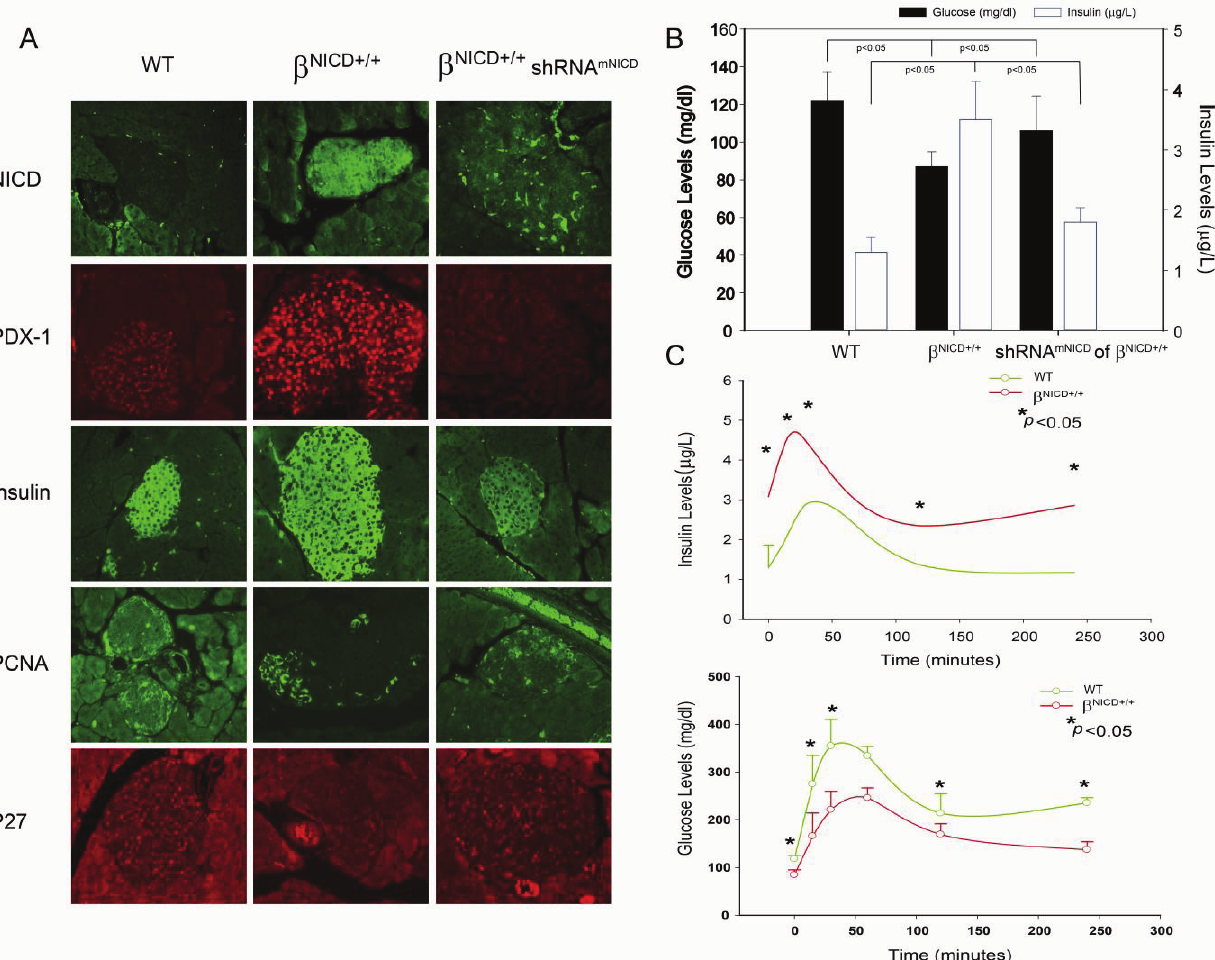
Figure 3. Overexpression of NICD-induced increase of PDX-1 expression is accompanied by the development of hypoglycemia and hyperinsulinemia in a β NICD+/+ transgenic mouse model. ( A ) Whole pancreatic tissues isolated from control mice (WT), β NICD+/+ mice and β NICD+/+ treated with shRNA mNICD were fixed in 4% (v/v) paraformaldehyde and embedded in paraffin. Immunohistochemistry analyses were performed using antibodies against NICD, PDX-1 (1:200), insulin (1:75), PCNA and p27. Fluorescence was developed using cy3- or FITC-conjugated secondary antibody. Photomicrographs were taken under 100× magnification. ( B ) Fifty (50) μ L of whole blood samples were collected from control mice (WT), β NICD+/+ mice and β NICD+/+ mice treated with shRNA mNICD and spun to separate the serum. Glucose levels were measured using a Beckman-Coulter Glucose Analyzer 2 (Coulter-Beckman, Fullerton, CA, USA), and presented as mean ± S.E.M. in mg/dl. Insulin levels were determined using a mouse insulin ELISA kit from Mercodia (Linco Research, St. Charles, MO, USA) and presented as mean ± S.E.M. in μ g/L. ( C ) Control mice (WT) and β NICD+/+ mice at age of 6 months were fasted 6 hours before collection of blood . Grouped mice were then given 1.2 g glucose/kg body weight via ip samples as T 0 injection, followed by collection of blood samples at 15, 30, 60, 120 and 240 minute after injection of glucose. Glucose and insulin levels were measured as described